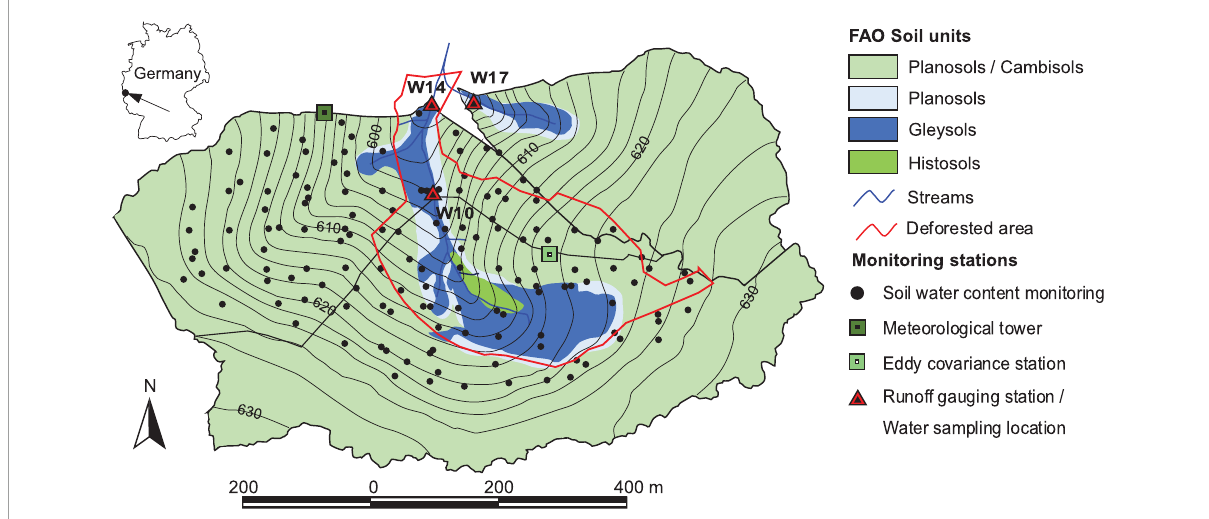
FIGURE1 Map of Wüstebach catchment including soil type, the three water sampling stations (W10, W14, W17) and their (sub) catchment area (modified from Wiekenkamp et al., 2016).